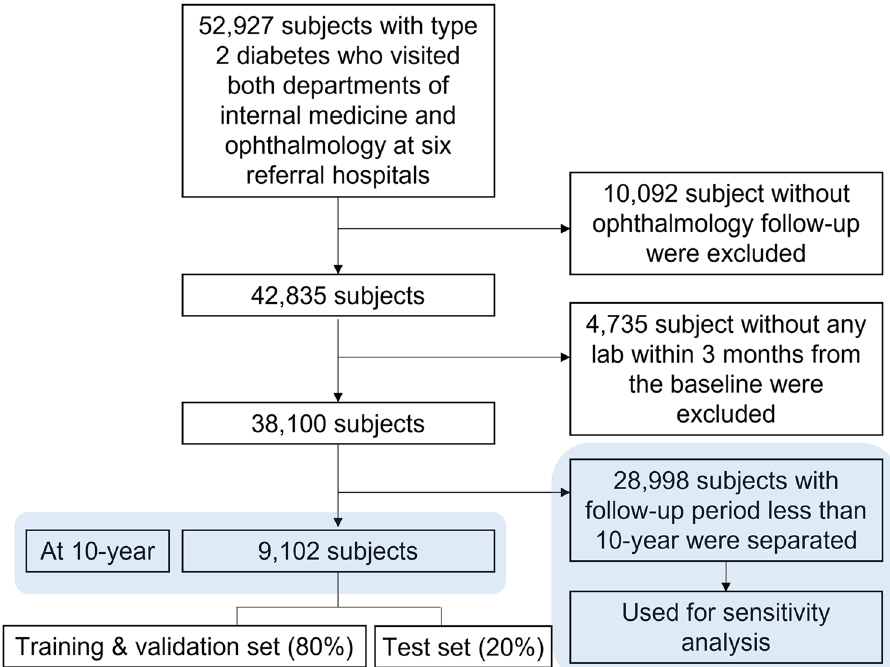
Figure 2. Dataset used in development, validation, and test of diabetic retinopathy risk prediction. This flowchart shows the process of obtaining and cleaning the